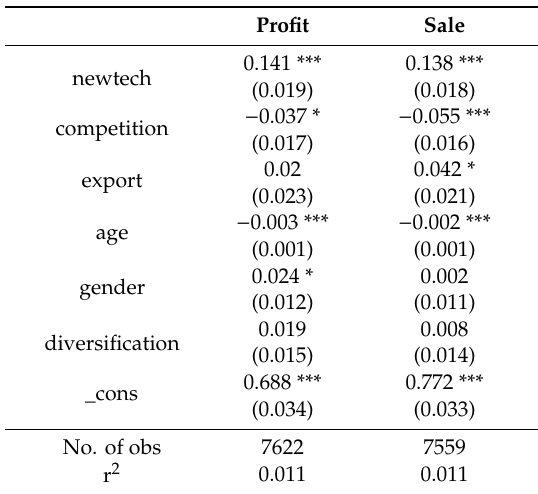
Table 4. Regression result (hypothesis H1).